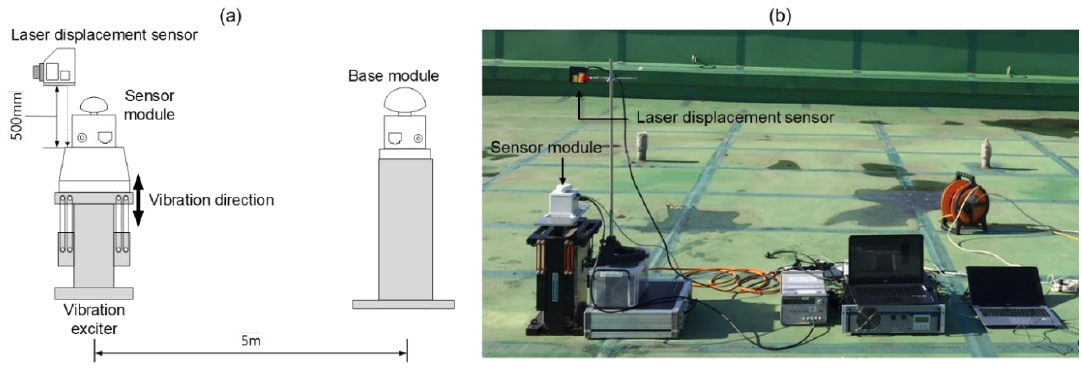
Figure 4. Overview of the lab-scale experiment: ( a ) schematic diagram of experiment configuration and ( b ) a photo taken after the sensor module installation.